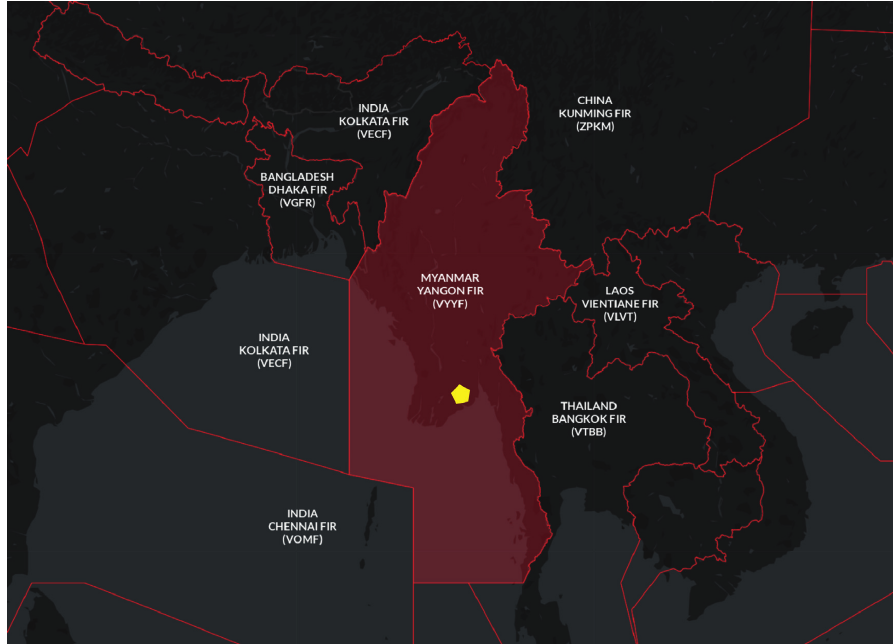
Figure 3: Study area. The red box shows the Flight Information Region (FIR) coverage area of Yangon International Airport Control (Yellow Polygon) [11].